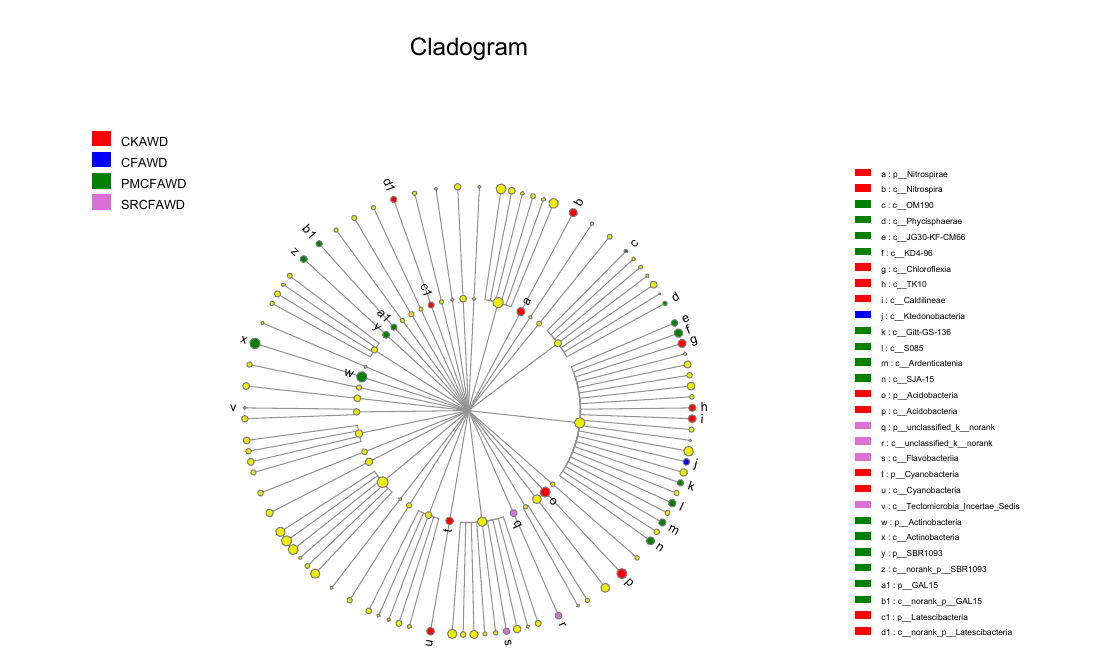
Figure 6. Linear discriminant effect size analysis cladogram of comparison between the unamended control (CK), chemical fertilizers (CF), pig manure plus chemical fertilizer (PMCF), and rice straw plus chemical fertilizer (SRCF) under alternate wet–dry (AWD) conditions. The subsequent colors stand for the abundance of individual taxa. Only taxa meeting a linear discriminant analysis significance threshold of 2.5 were shown. The domain of the cladogram is phylum and class. CKAWD showed CK treatment under AWD condition and so on.